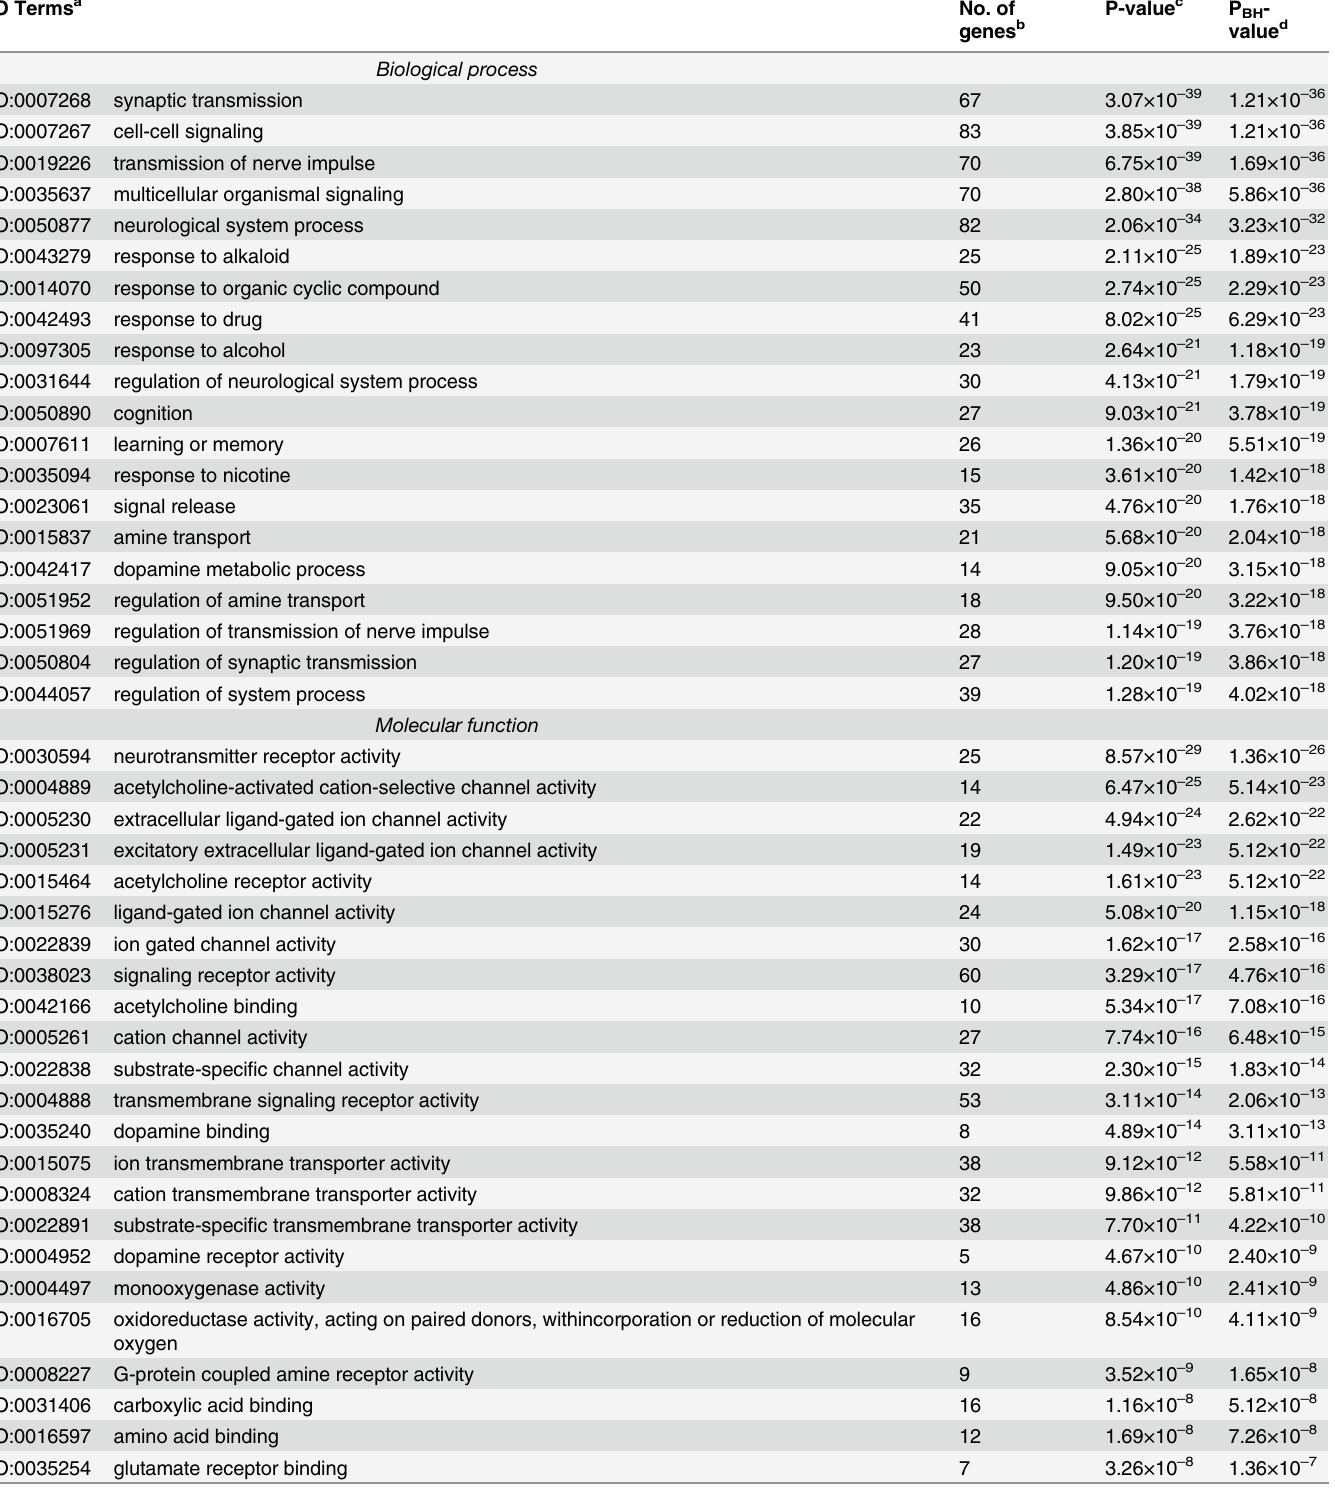
Table 1. Gene Ontology terms enriched in nicotine addiction-related genes